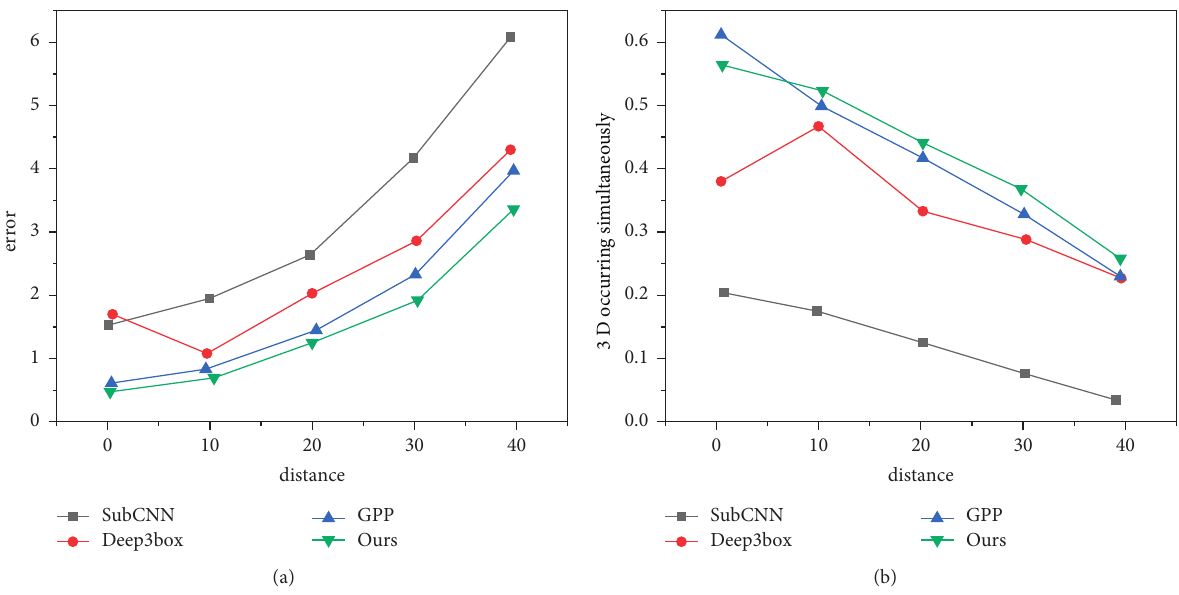
Figure 2: Comparison of 3D detection experiments on KITTI data set. (a) Experimental comparison of center point distance equalization error. (b) Experimental comparison of 3D cross-parallel